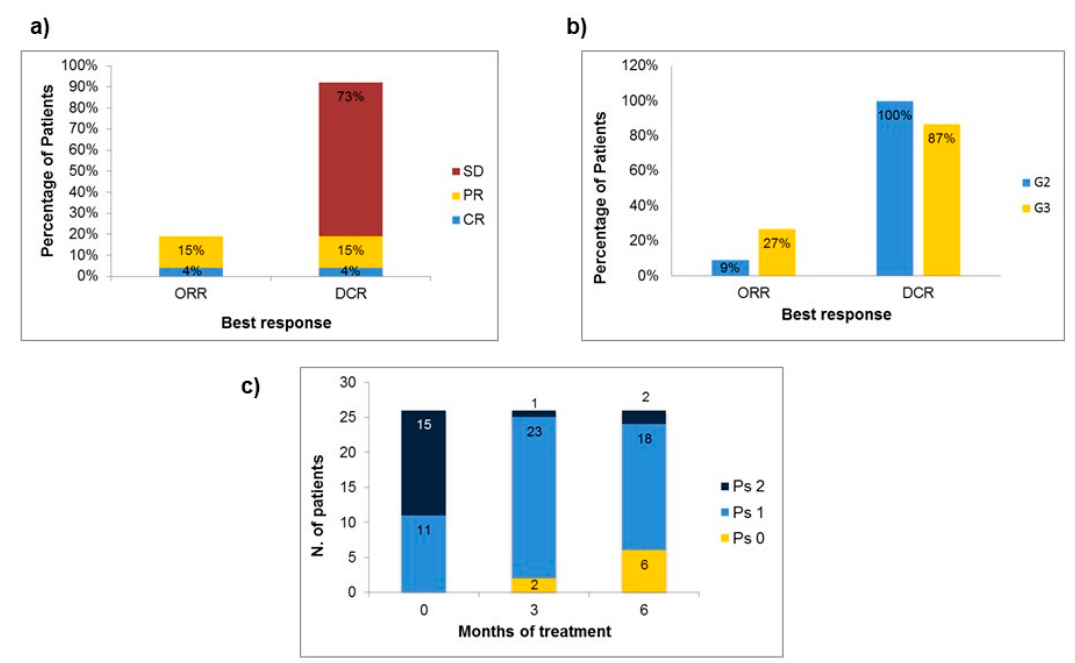
Figure 1. Histogram representations of activity and clinical benefit of mTMZ. Response rates with mTMZ in all patients ( a ) and according to grading (G2 vs G3) of the tumor ( b ). Improvement of ECOG PS over 3 and 6 months of treatment ( c ). CR = Complete Response; DCR = Disease Control Rate; ORR = Overall Response Rate; PR = Partial Response; PS = Performance Status; SD = Stable Disease.